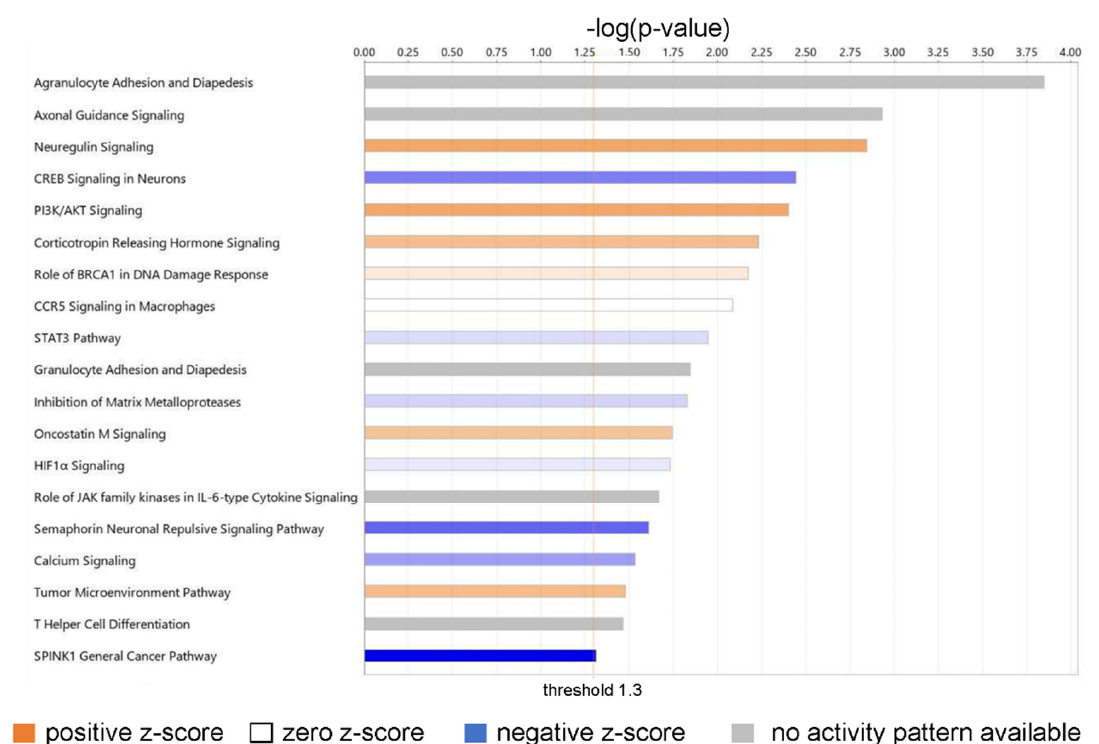
Figure 5. Canonical pathways of biological significance activated in our dataset. Significance values are displayed as − log of the p -value, calculated by the right-tailed Fisher’s exact test and which indicates the probability of association of molecules from our dataset with the canonical pathway by random chance alone. All pathways shown have − log( p -value) > 1.3 or p < 0.05.